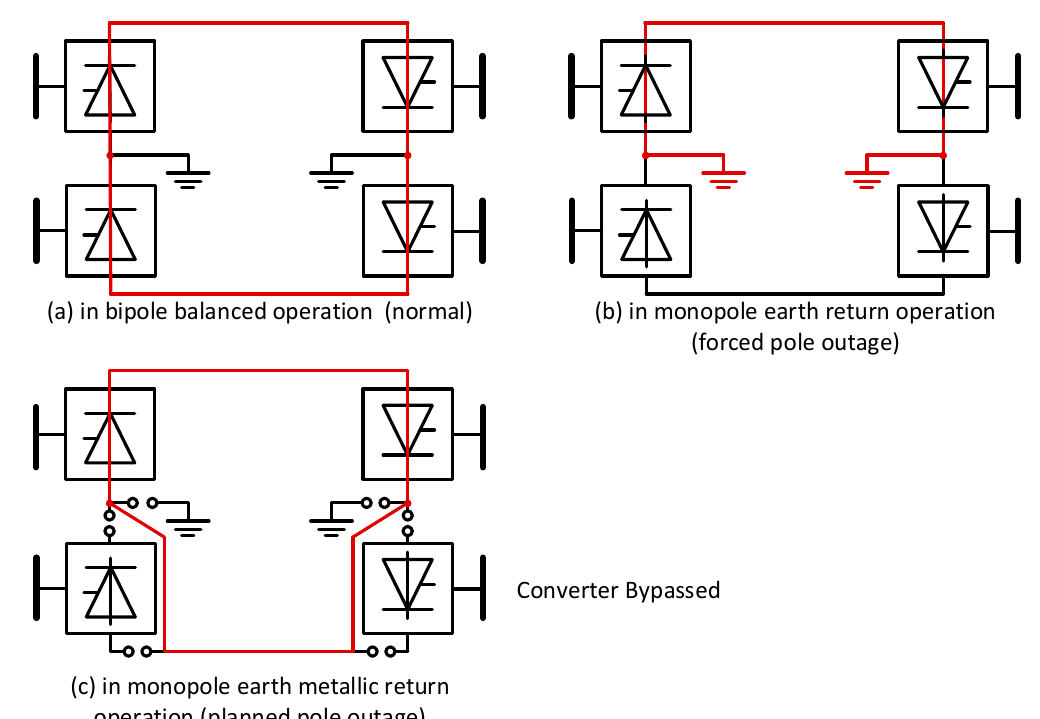
Figure 9. Operating states of a bipole HVDC link: ( a ) Normal operation; ( b ) Monopole due to a fault on one pole and using earth return; ( c ) Monopole operation and using metallic return path.